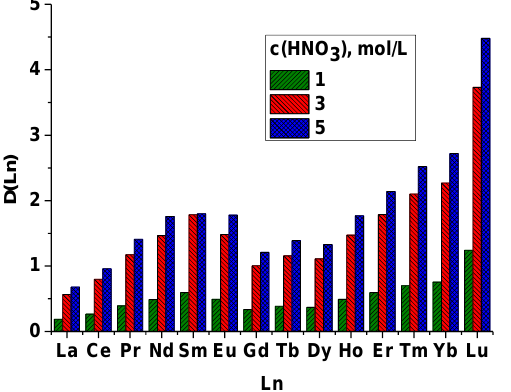
Figure 6. Dependence of the distribution ratio on the order number Ln at different contents of nitric acid.